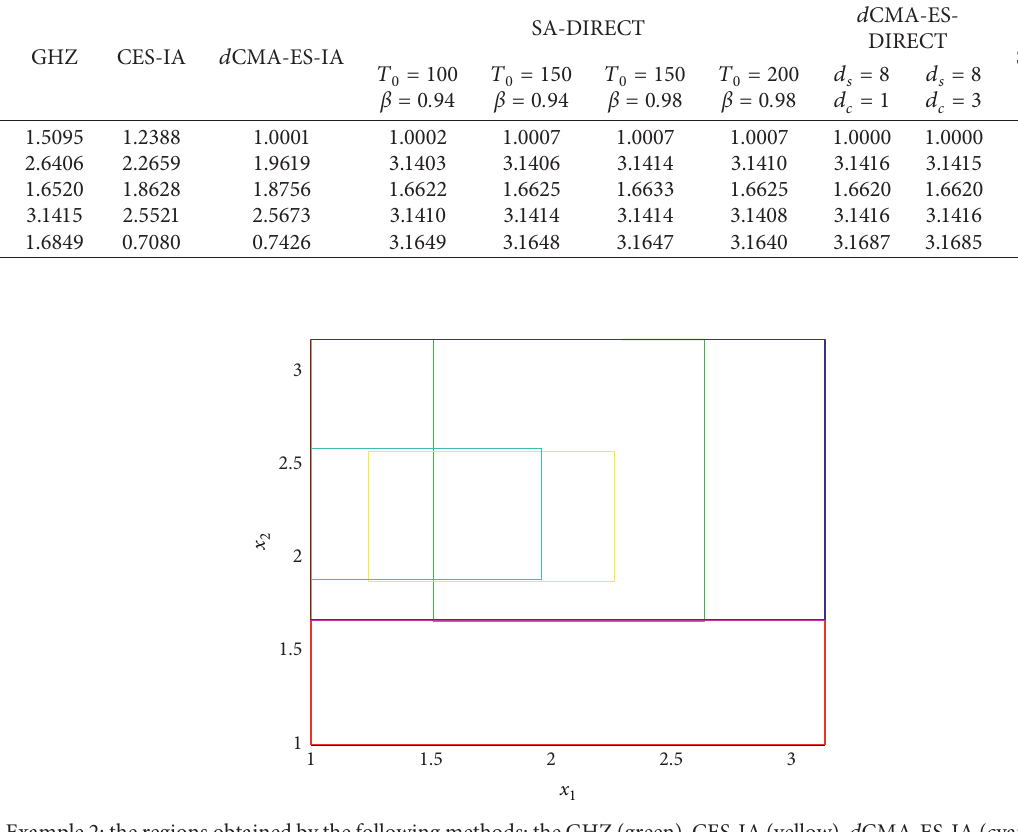
� 8and d � 1 (magenta), and SA-FMINCON s c